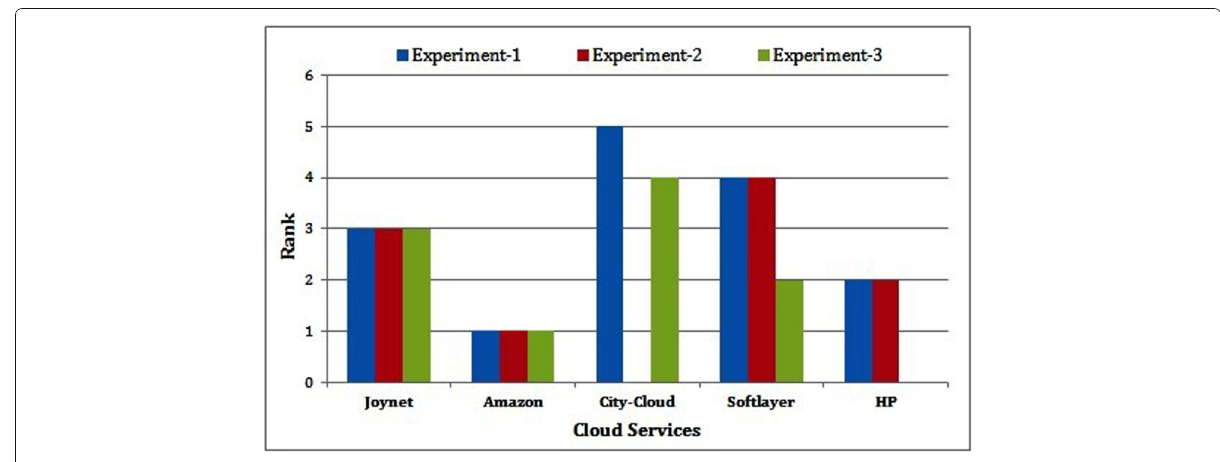
Fig. 2 Rank for Case Scenario 1